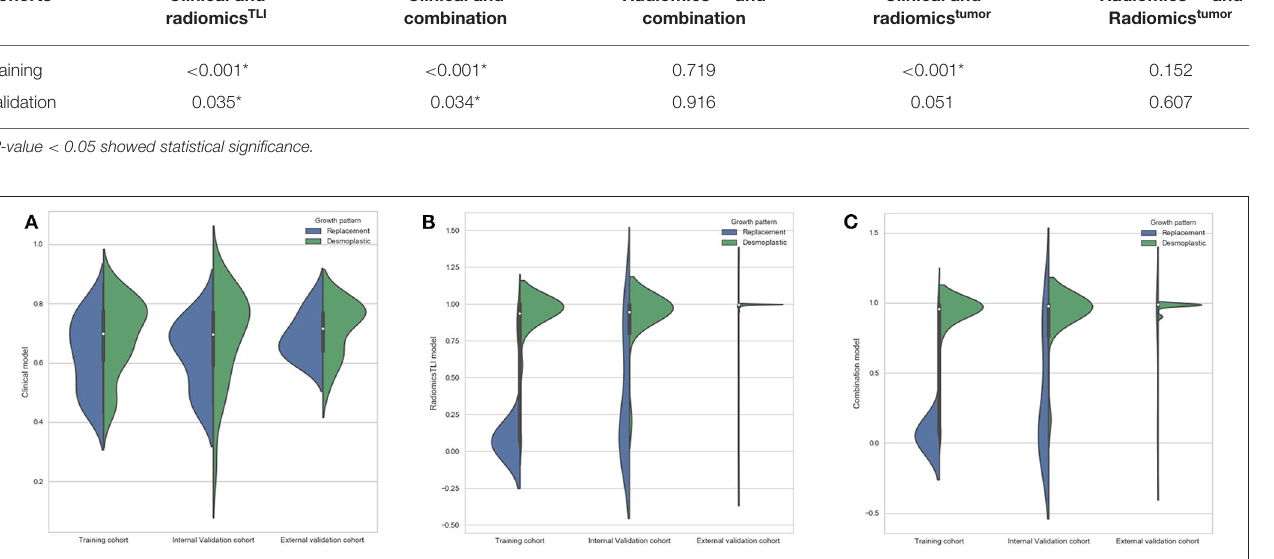
FIGURE 3 | (A) Violin graph of distribution of clinical model between replacement and desmoplastic HGPs. (B) Violin graph of distribution of radiomics TLI model between replacement and desmoplastic HGPs. (C) Violin graph of distribution of combination model between replacement and desmoplastic